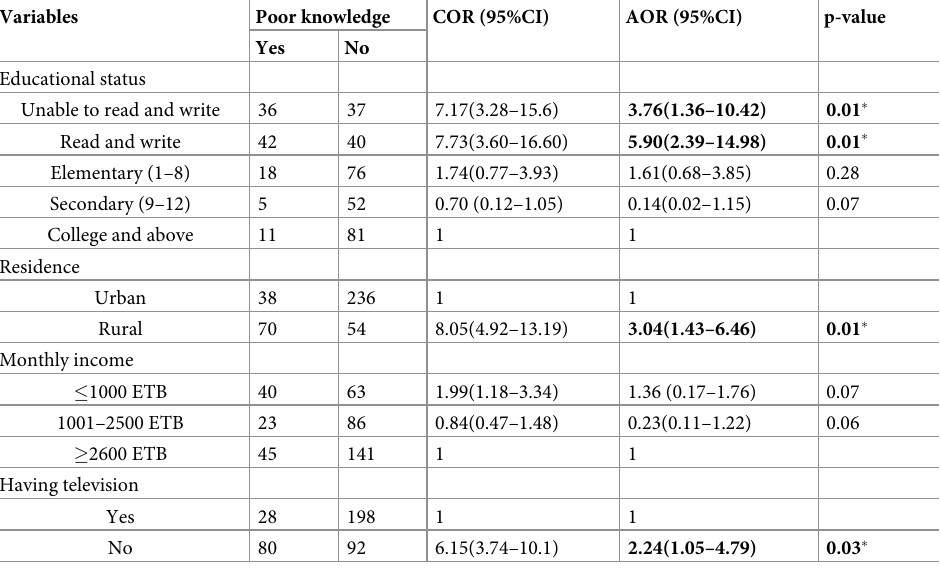
Table 3. Factors associated with poor knowledge among outpatient service visitors at Debre Markos comprehen- sive specialized hospital, Amhara regional state, Ethiopia, 2020.